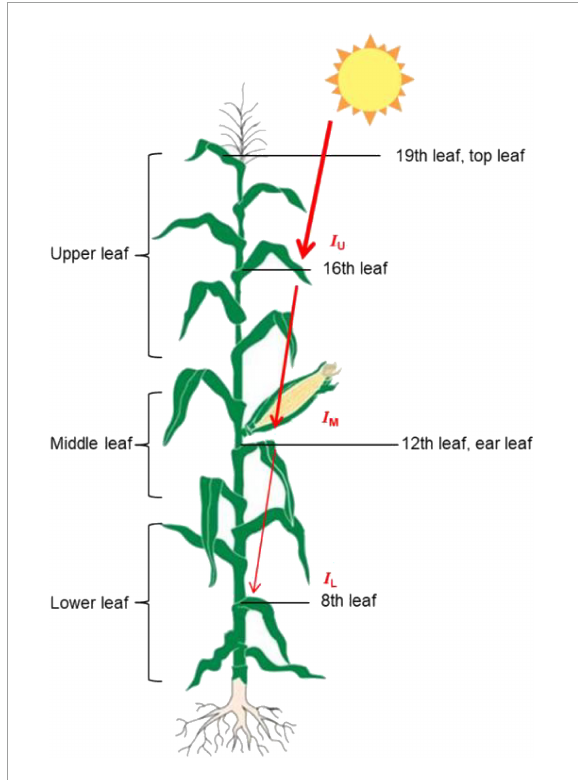
FIGURE2 A schematic model depicting the leaf position and incident light of maize. The I U , and I o , I M , and I L are PAR values on a horizontal level at upper, middle and lower leaf layers. The thickness of the red arrows represent the light density that is intercepted by different leaf